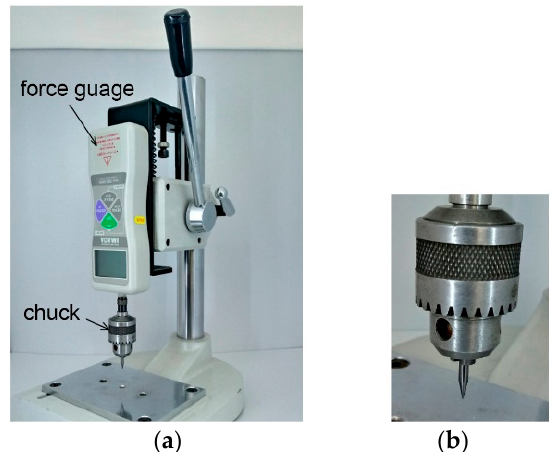
Figure 4. ( a ) Push-pull gauge stand assembled with a force gauge. A chuck is mounted on a spindle. ( b ) Inserted tapered tip into the chuck.